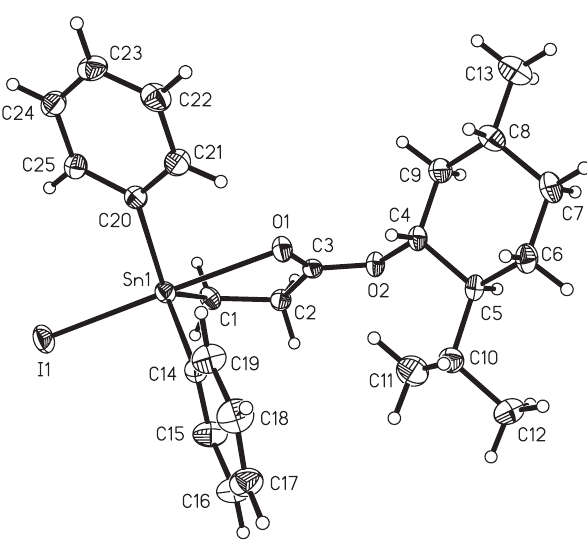
Figure 2: The molecular structure of 2